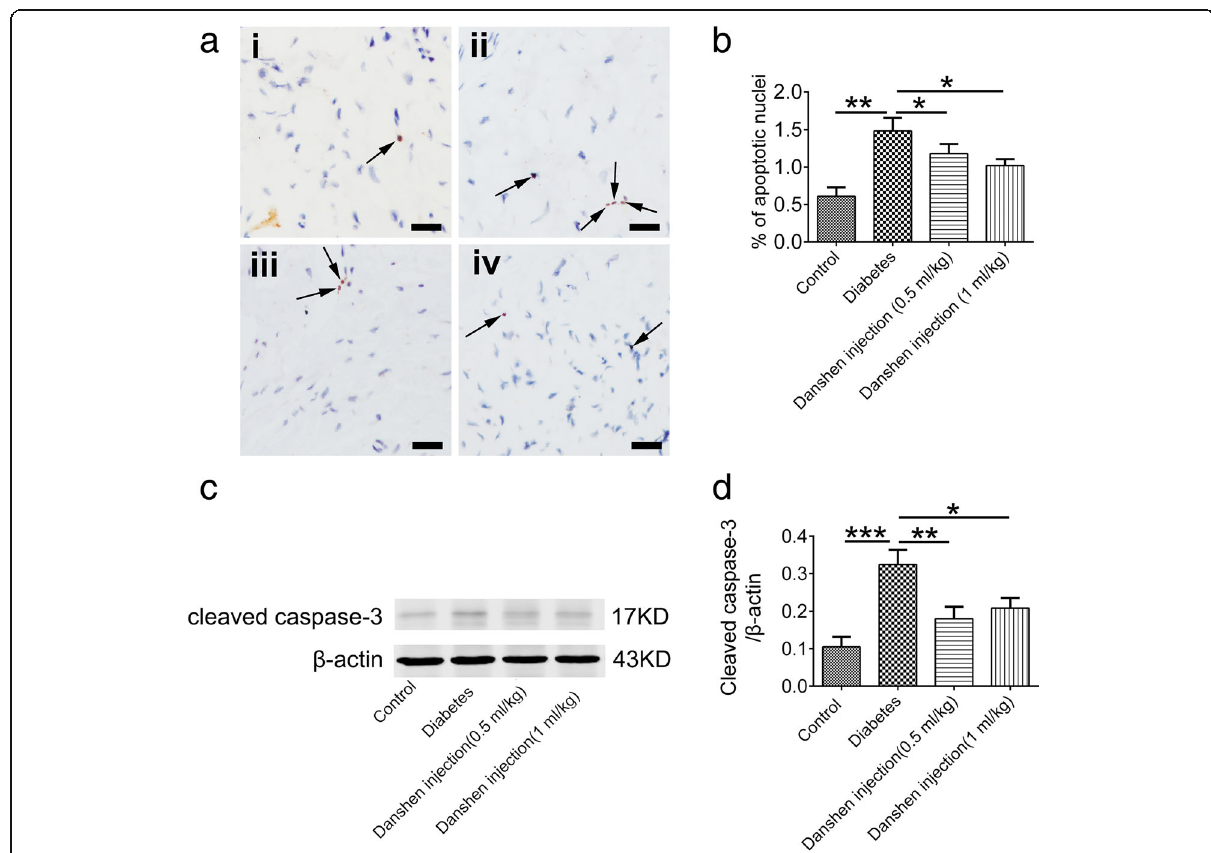
Fig. 5 Danshen injection alleviated apoptosis. a Representative images of apoptotic cells in the corpus cavernous tissue by a TUNEL assay are shown. (i) Control group; (ii) Diabetes group; (iii) Danshen injection group (0.5 mL/kg); (iv) Danshen injection group (1 mL/kg). Hyperglycemia triggered an increase in the number of apoptotic cells (arrow), whereas Danshen injection potentially reduced the number of apoptotic cells. b Apoptotic nuclei were quantified. Data are presented as the mean ± standard error of the mean (S.E.M.). * P < 0.05; ** P < 0.01. Scale bar: 20 μ m. c The expression of cleaved caspase-3 was detected by western blot analysis. Cleaved caspase-3 was upregulated in the diabetes group, which was prevented by the Danshen injection. d Data are presented as the mean±standard error of the mean (S.E.M.) for five rats per group. * P <0.05; ** P <0.01